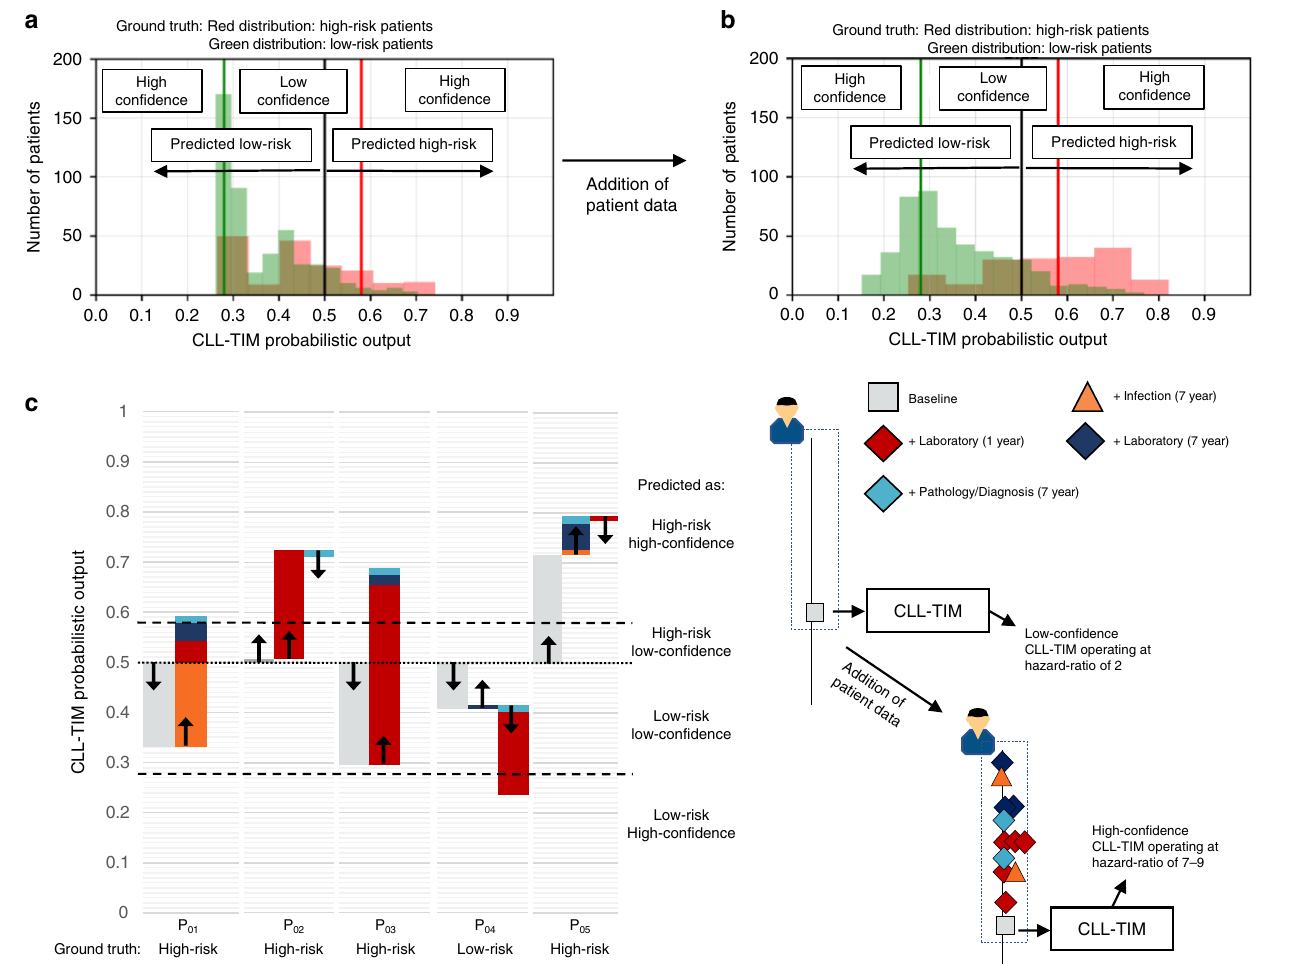
patientsGround truth: Red distribution: high-risk patients Green distribution: low-risk